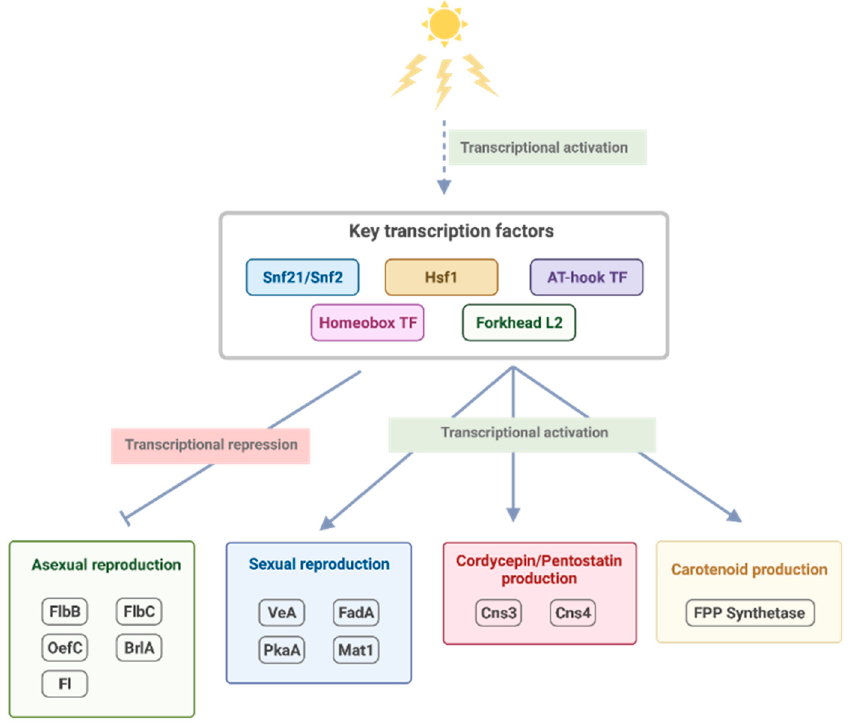
Figure 7. The putative light-mediated regulatory events that promote sexual growth and secondary metabolite production identified from the current study.